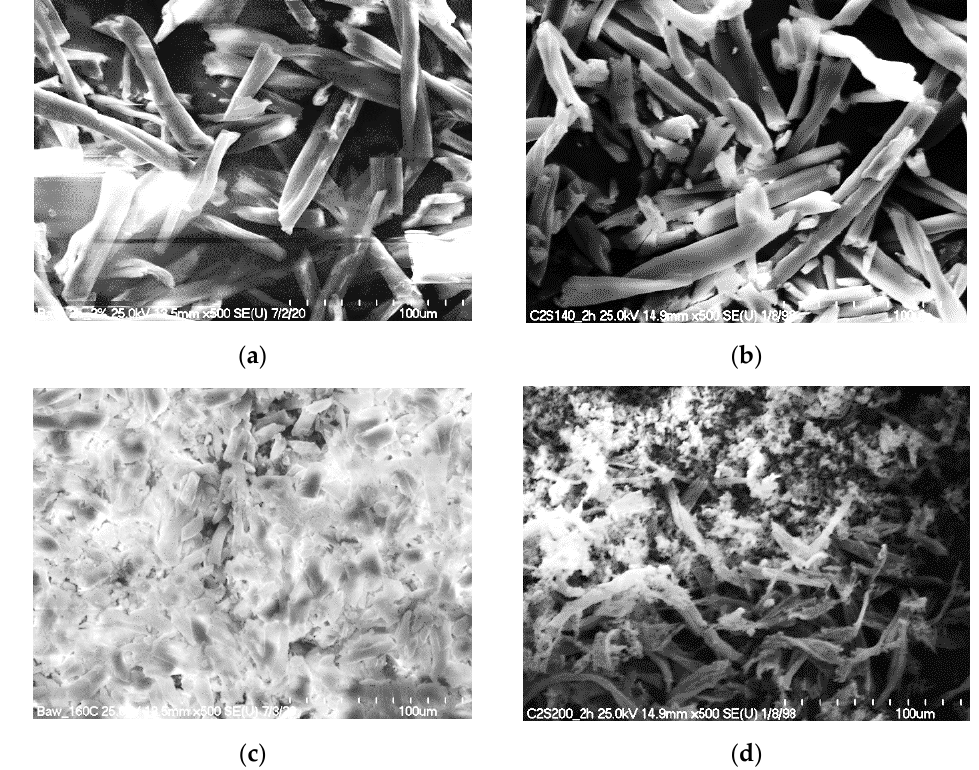
Figure 3. SEM pictures of the solid residue after hydrolysis of cotton, depending on the temperature of the process (2 h, 2% H 2 SO 4 ): cotton treated at ( a ) 120 °C, ( b ) 140 °C, ( c ) 160 °C, and ( d ) 200 °C.